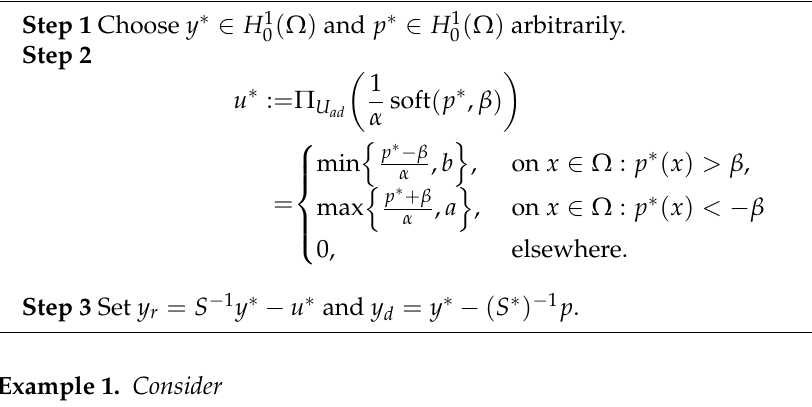
Algorithm 4 Construct the optimal control